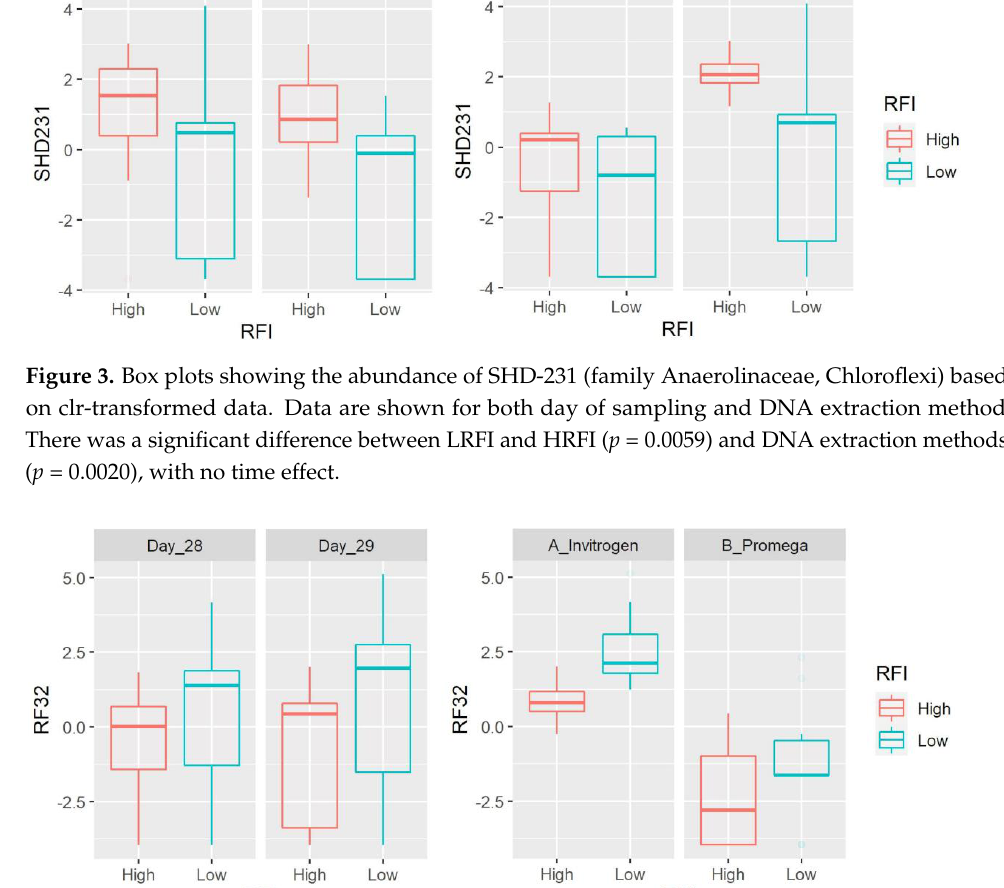
Figure 4. Box plots showing the abundance of RF-32 (Alphaproteobacteria) based on clr-transformed data. Data are shown for both day of sampling and DNA extraction method. There was a significant